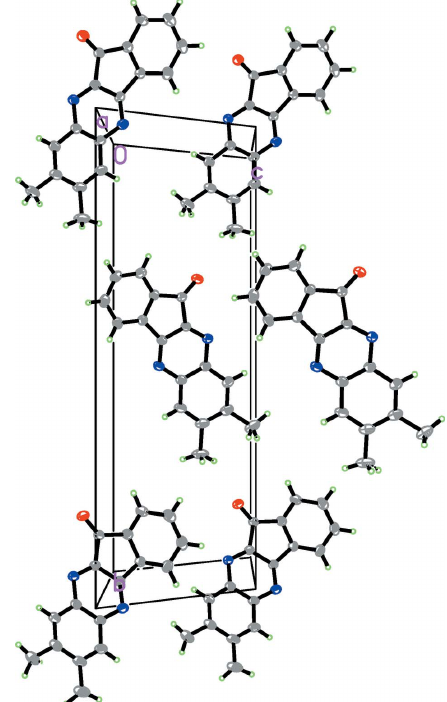
Figure 2 A packing diagram of the title compound.